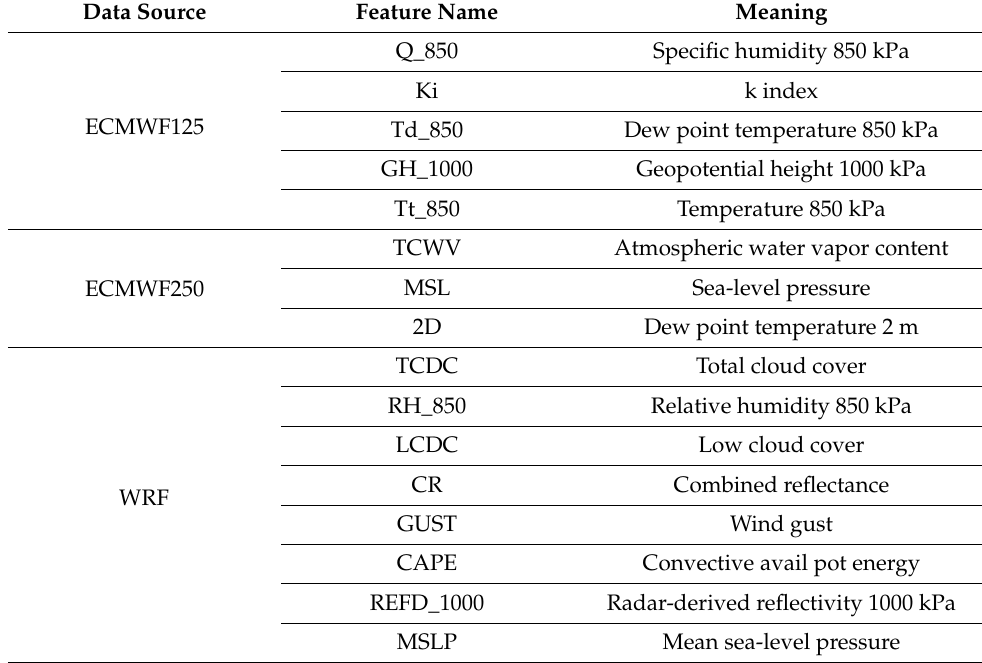
Table 2. Description of the selected